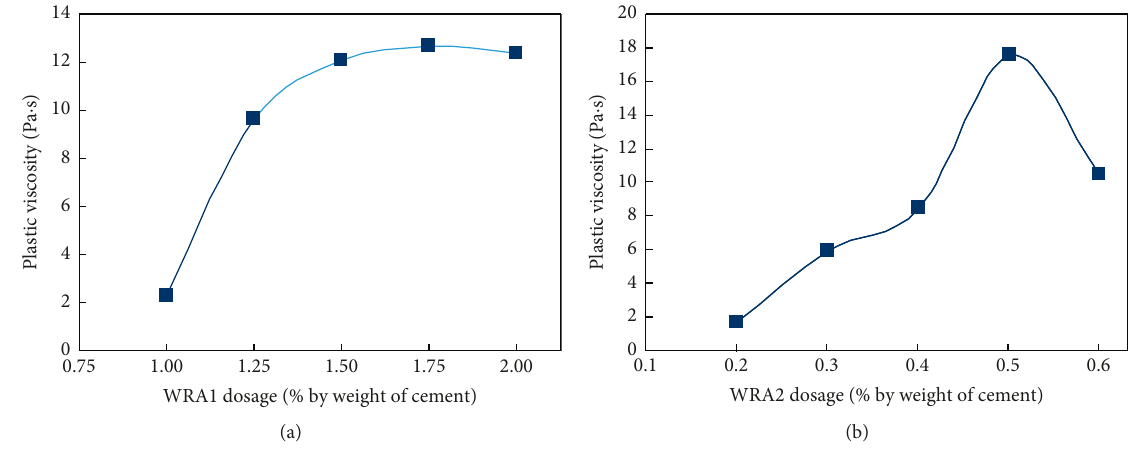
Figure 3: Plastic viscosity of CGCBM mixed with different dosage of WRA.